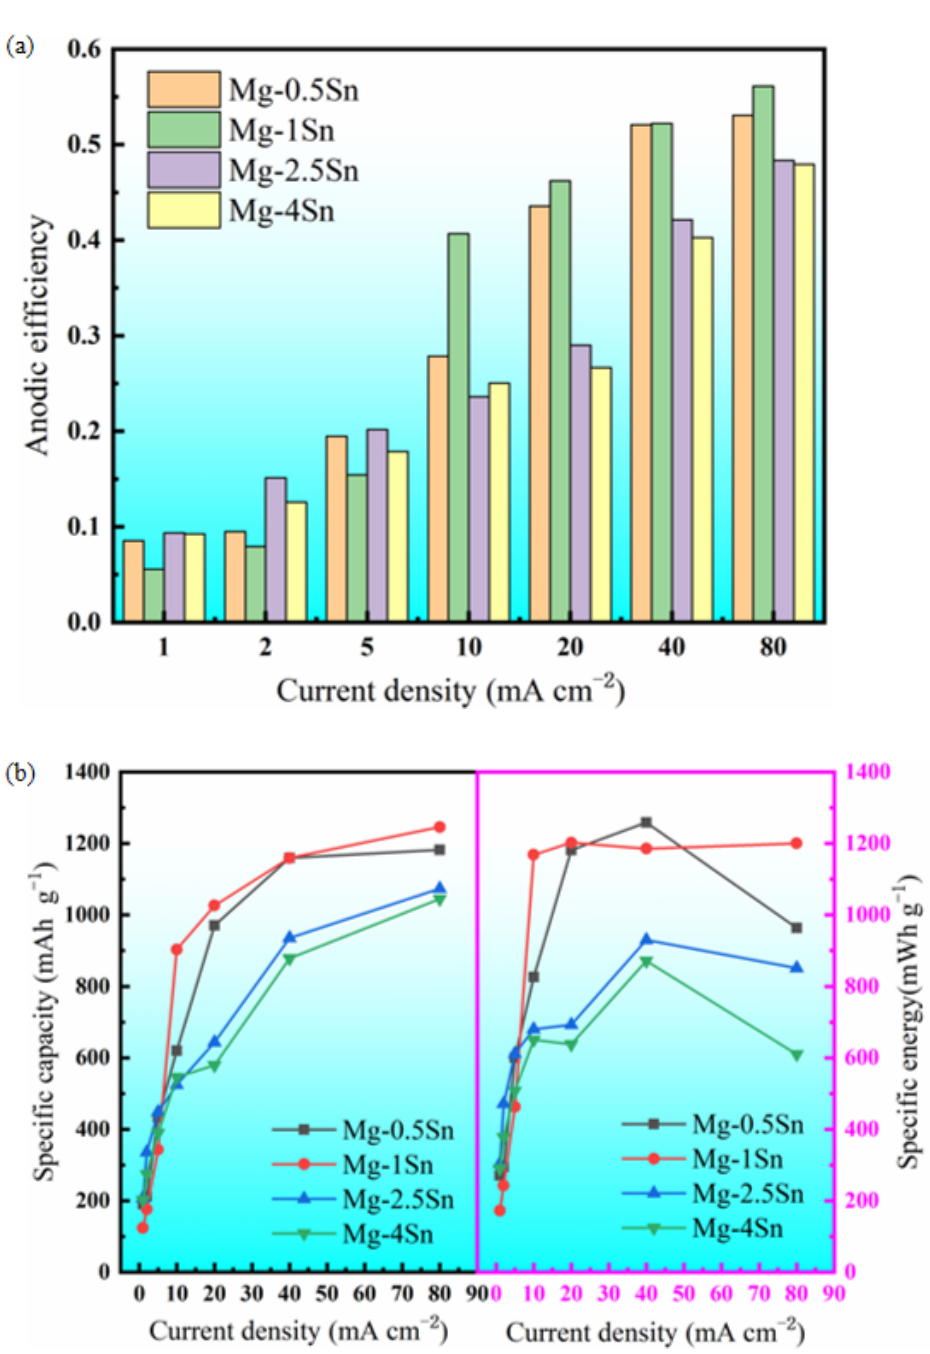
Figure 9. The discharge performance of Mg- x Sn anode in magnesium–air battery under different current densities: ( a ) anodic efficiency, and ( b ) discharge capacity and specific energy.